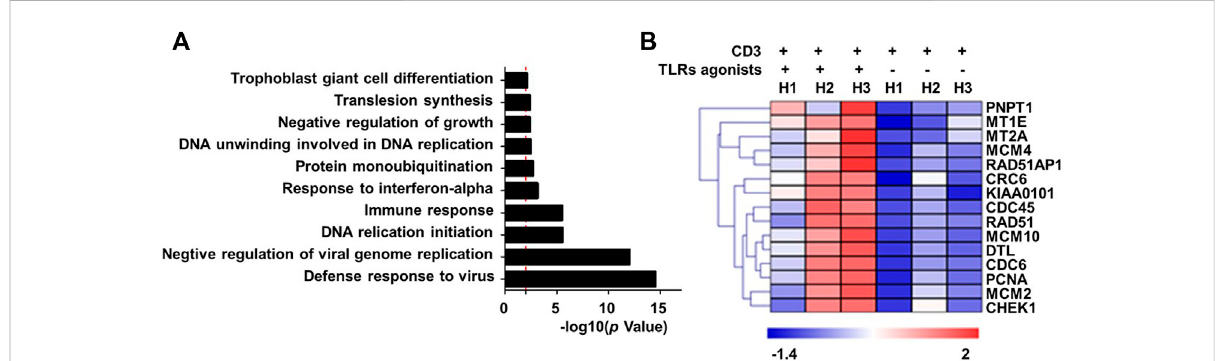
FIGURE 2 Co-stimulation with a combination of TLR1/2, TLR2/6, and TLR5 agonists enhances the transcriptional induction of proliferative-related genes in human blood-derived CD8 + T cells responding to TCR triggering. CD8+T cells puri fi ed from human PBMCs were stimulated with anti-CD3 beads inthepresence orabsenceofacombinationofTLR1/2agonist,TLR2/6agonist,andTLR5agonist. Cellswereharvested24 hlaterforextracting total RNA, which was subjected to RNA sequencing. The differentially expressed genes showing > 2-fold change between minus and plus TLR agonists groups were clustered based on Gene Ontology (GO) enrichment analysis (A) . Shown in (B) is the heatmap of representative proliferation- related genes that were identi fi ed to be co-stimulated by TLR agonists. H1 to H3 represent samples from three healthy